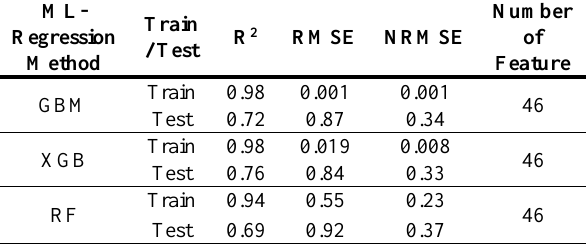
Table 5. Accuracy assessment of three machine learning regression